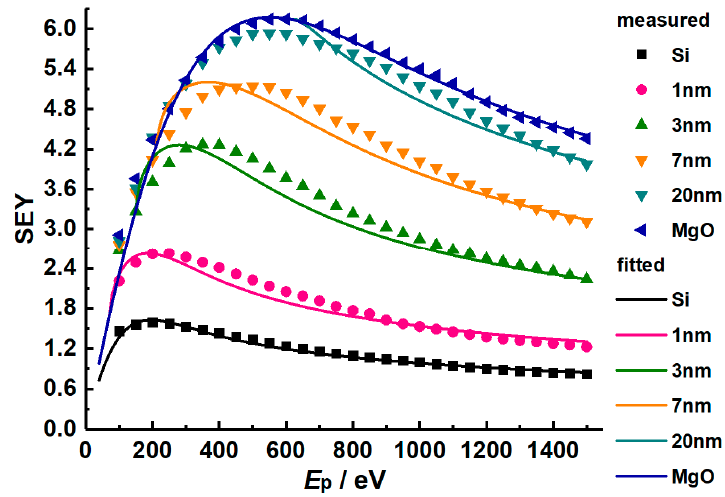
Figure 8. Fitted (lines) and measured (symbols) SEY curves of MgO/Si double-layer samples. Table 2. Fitting parameters of SEY curves for MgO/Si double-layer samples.